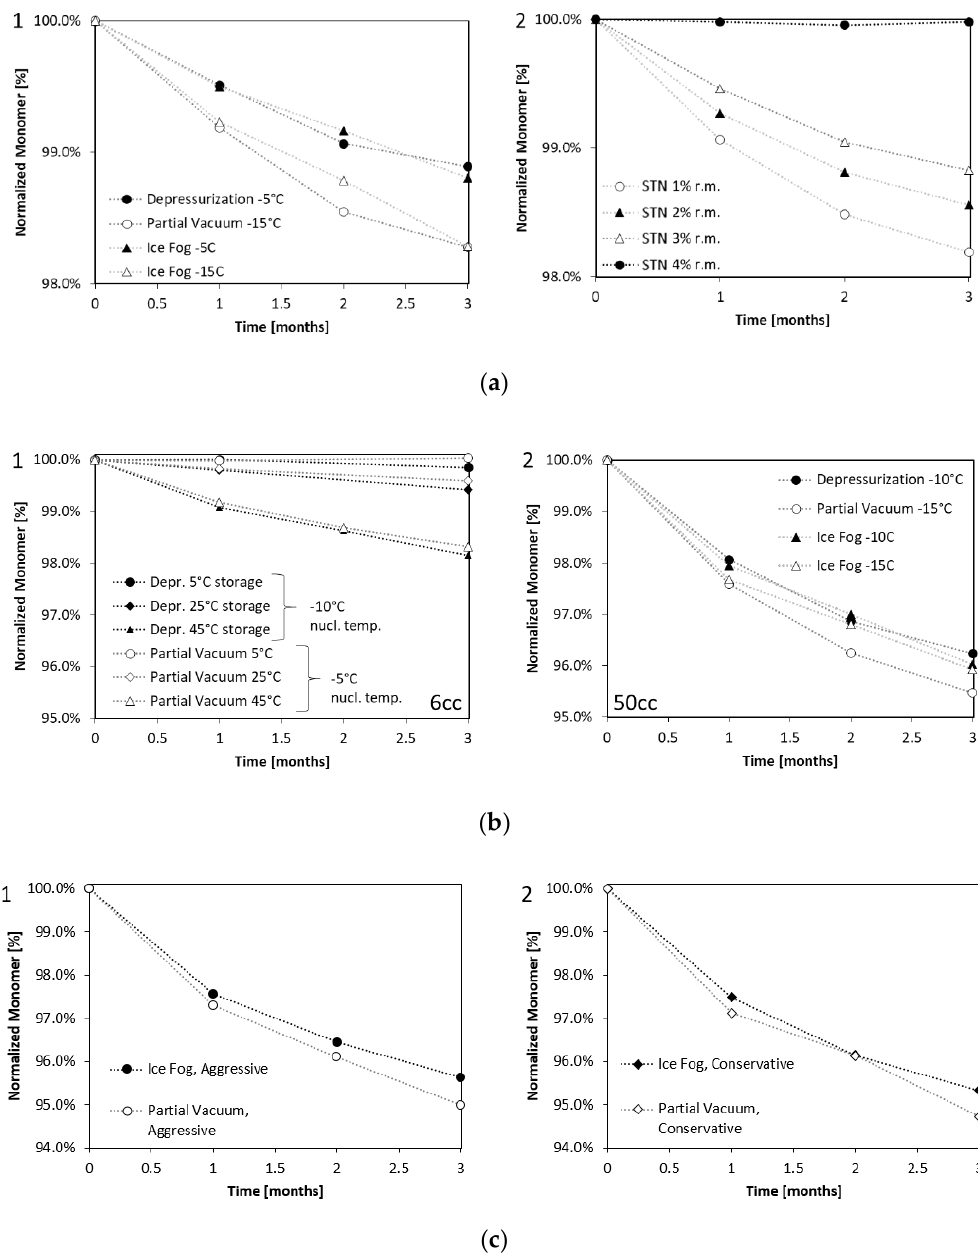
Figure 2. Loss of Monomer analyzed by SEC. ( a1 ) mAb1 at 100 mg/mL after 3 months’ storage at 40 °C lyophilized in 20 cc vials with three different techniques compared to ( a2 ) stochastically nucleated samples (STN) with defined residual moisture level (r.m.). ( b1 ) Enzyme at 2.5 mg/mL after storage at 5 °C, 25 °C, and 45 °C for three months lyophilized in 6 cc vials, or ( b2 ) lyophilized in 50 cc vials and stored at 60 °C for 3 months. ( c ) Enzyme at 2.5 mg/mL (nucleation temperature −15 °C) after storage at 60 ◦ C for three months lyophilized in 50 cc vials with “partial vacuum” and “ice fog” technique for conservative ( c1 ) and aggressive ( c2 ) lyophilization conditions. Nucleation temperatures and techniques are indicated in the